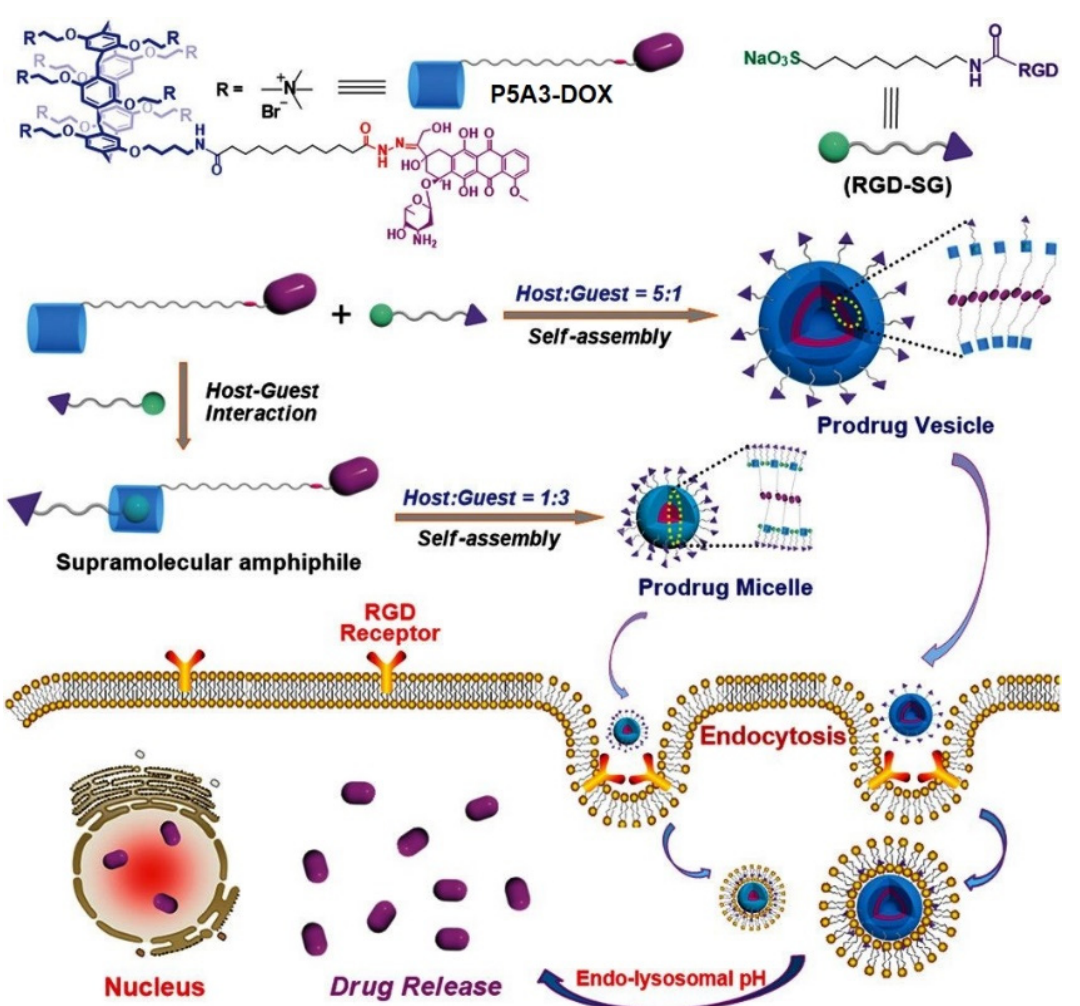
Figure 13. Chemical structures and schematic illustration of the controllable construction of P5A3 - based tumor-targeting supramolecular prodrug vesicles and micelles for tumor-targeting drug delivery. Reproduced with the permission of reference [92]. Copyright © Wiley 2018.